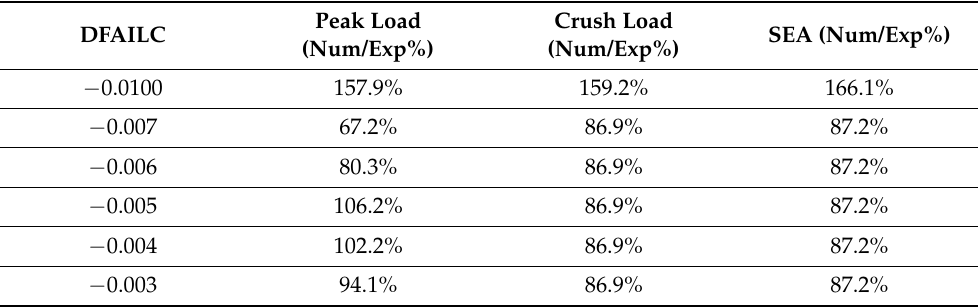
Table 3. The parametric study shows the effect of DFAILC in MAT54 on the peak load, crush and SEA of the circular tube [66].